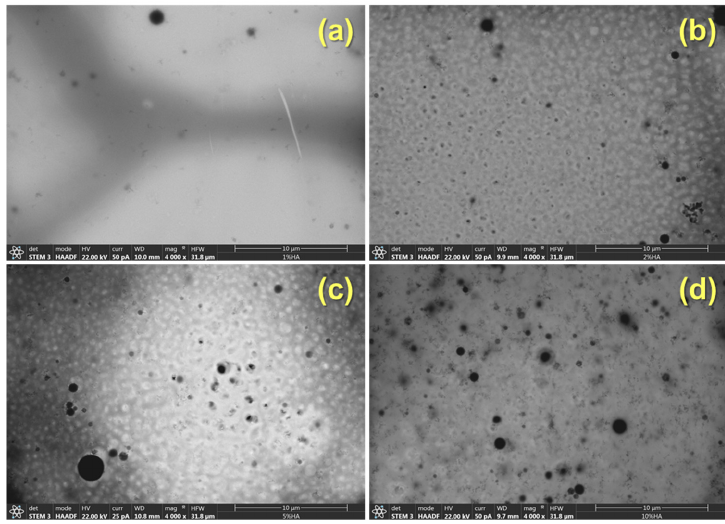
Figure 5. STEM images at low magnification of the PSF/HA nanocomposites under study: ( a ) 1%; ( b ) 2%; ( c ) 5%; and ( d ) 10% wt of HA, respectively.